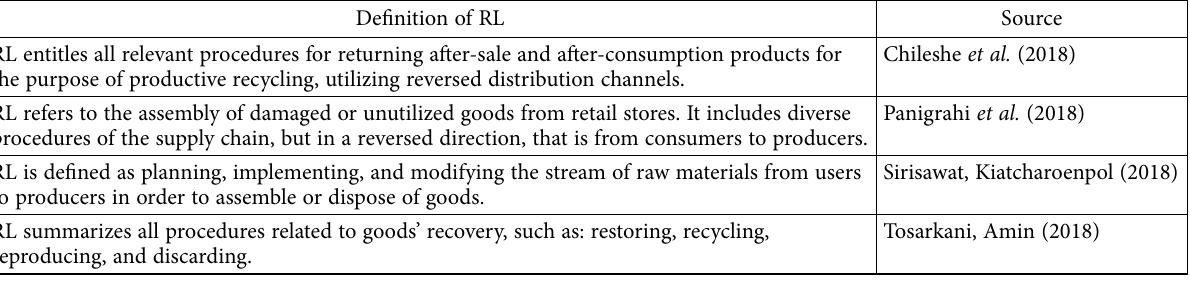
Table 1. Main definitions of RL (source: compiled by authors) Definition of RL